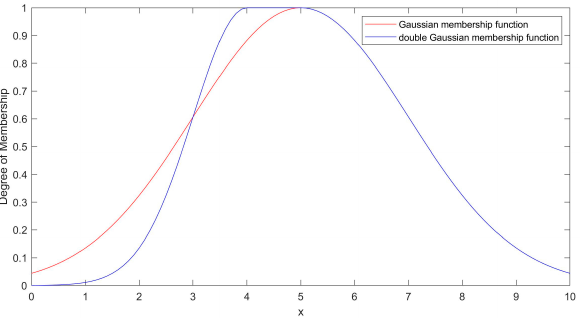
Figure 3. Gaussian membership function and double Gaussian membership function.